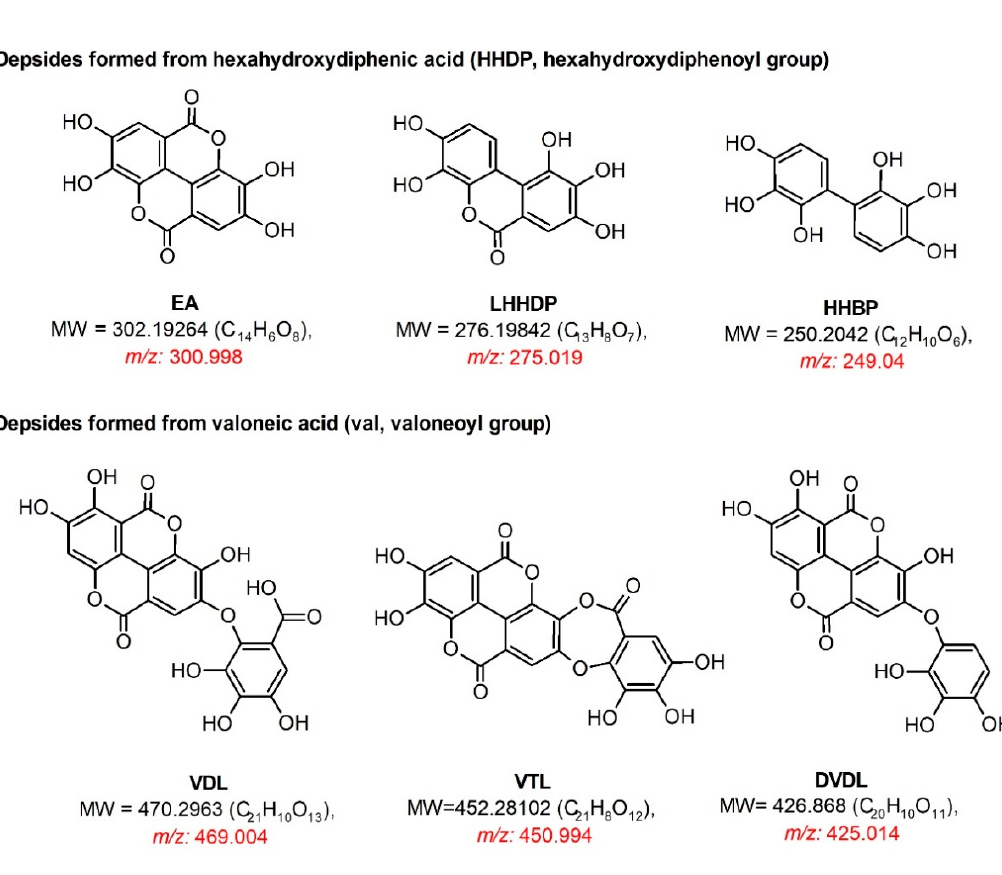
Figure 3. MS spectra of selected ellagitannins and products of their fragmentation (generated depsides). Abbreviations: GA, gallic acid; EA, ellagic acid; LHHDP, decarboxylated hexahydroxydiphenic acid monolactone; HHBP, 2,2’,3,3’,4,4’-hexahydroxybiphenyl; VTL, valoneic acid trilactone.